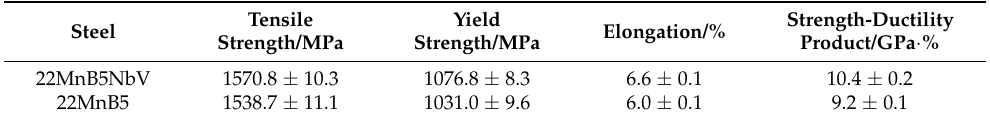
Table 2. Comparison of mechanical properties between 22MnB5NbV and 22MnB5 steel.